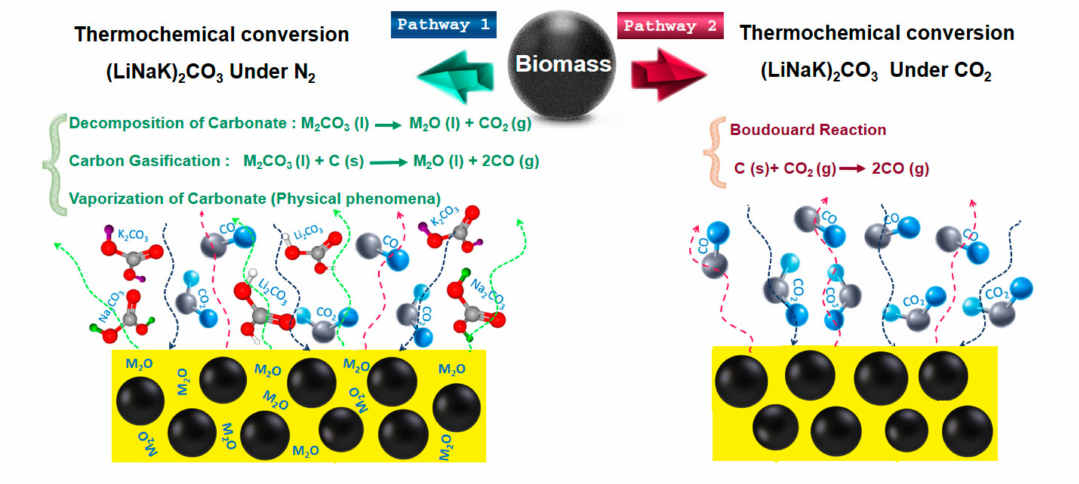
Figure 8. Graphical illustration of biomass thermochemical conversion in molten carbonate ([LiNaK] 2 (CO) 3 under N 2 and CO 2 at 900 ◦